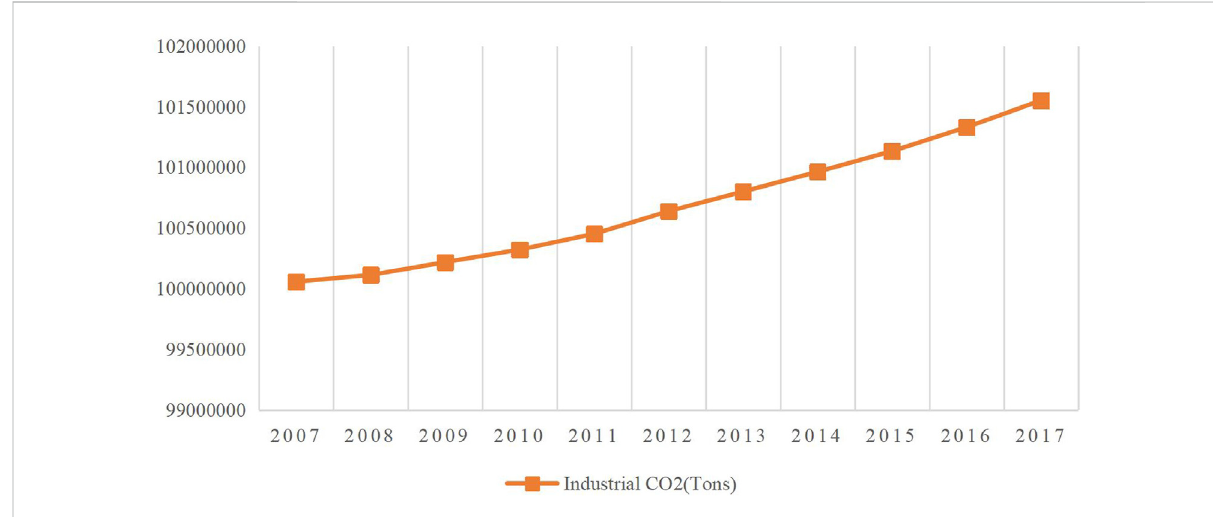
FIGURE 1 Industrial carbon dioxide emissions in China from 2007 to